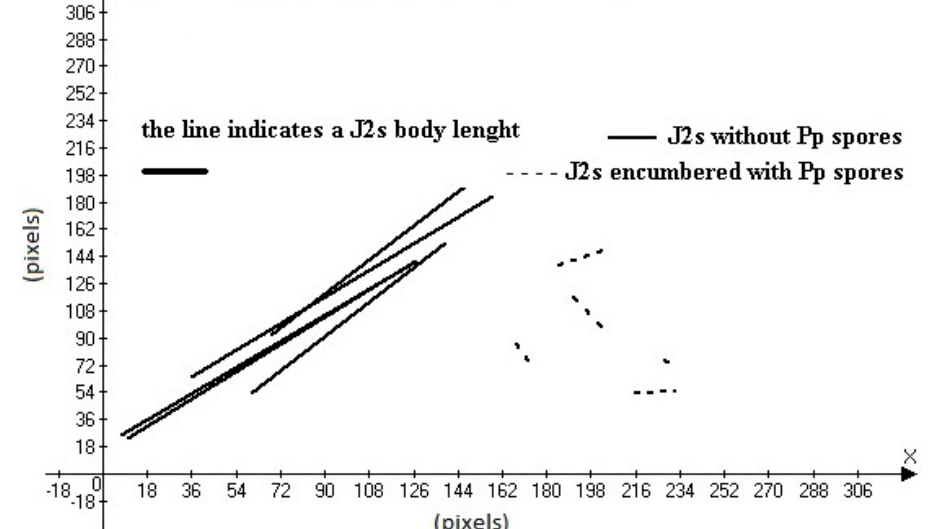
Figure 1. movement of second-stage Meloidogyne javanica juveniles (J2s) with and without Pasteuria penetrans attached en- dospores. Each line represents the movement of a single J2. Each position was estimated by joining positions of centroid body points, as the nematode